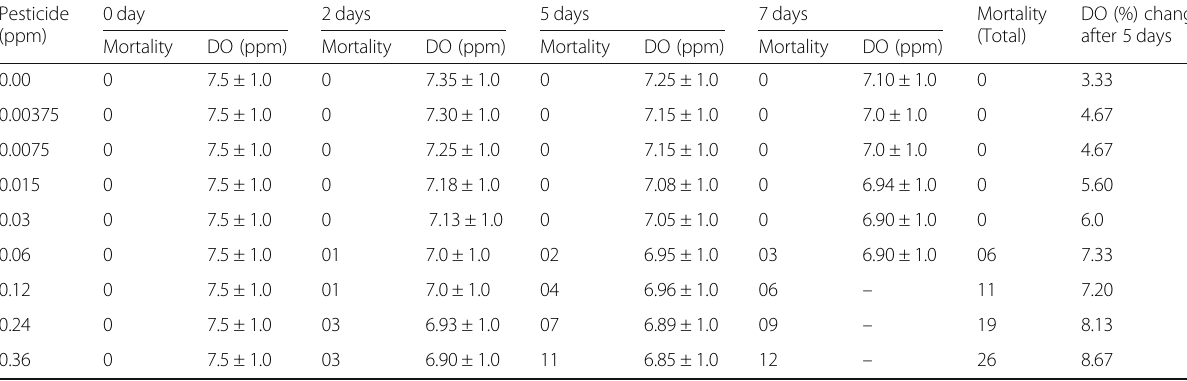
Table 1 Changes in dissolved oxygen and fish mortality during the experimental period Pesticide